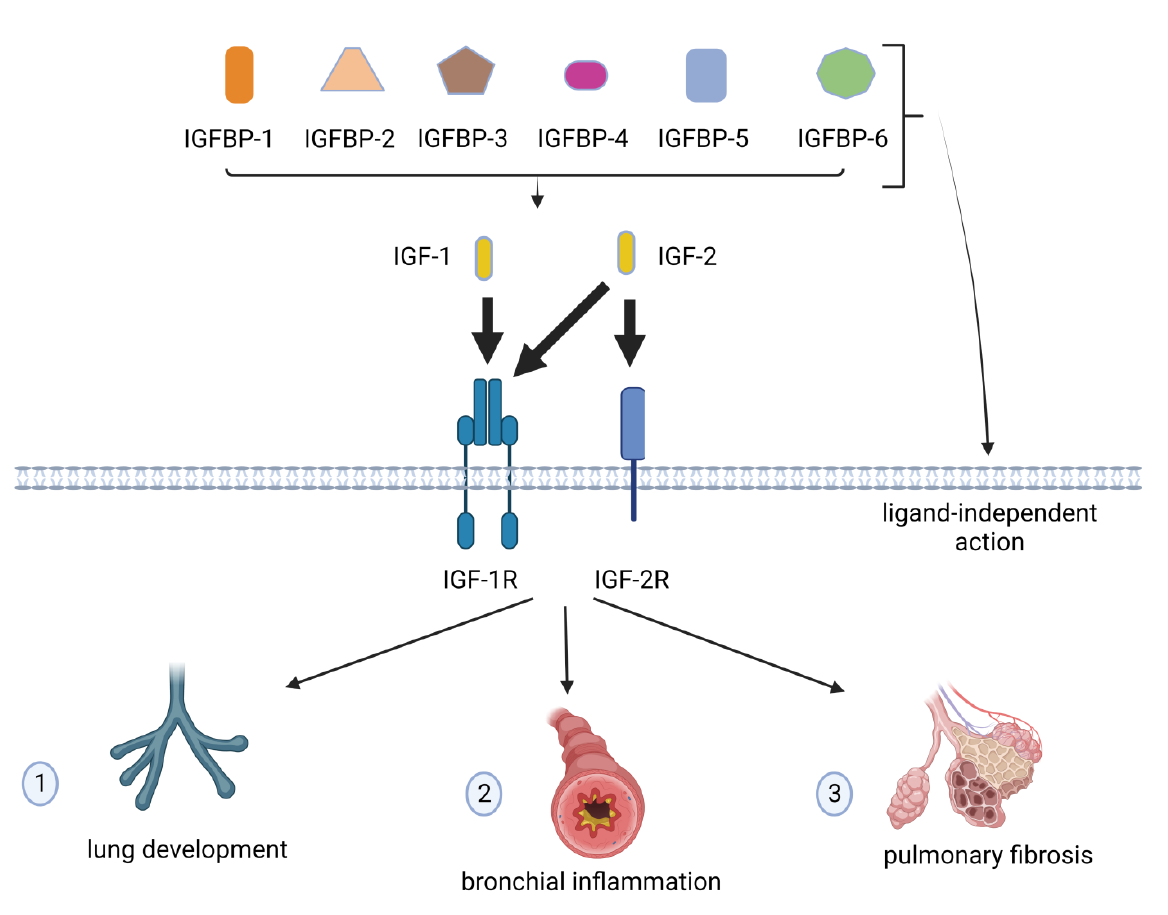
Figure 1. The insulin-like growth factor (IGF) system. Two IGF ligands (IGF-1 and -2), two receptors (IGF-1 receptor (IGF-1R) and type-2 IGF receptor (IGF-2R)), and six forms of IGF-binding proteins (IGFBPs) are shown. IGF-1 and IGF-2 bind to IGF-IR with high affinity, whereas IGF-2 can also bind to IGF-2R. IGFBPs can act by enhancing or inhibiting IGF actions as well as determining ligand- independent effects. In the respiratory system, the IGF/IGF-R/IGFBP system is involved in: (1) lung development, (2) bronchial inflammation, and (3) pulmonary fibrosis. Not all the molecules involved in this system are shown; see text for further